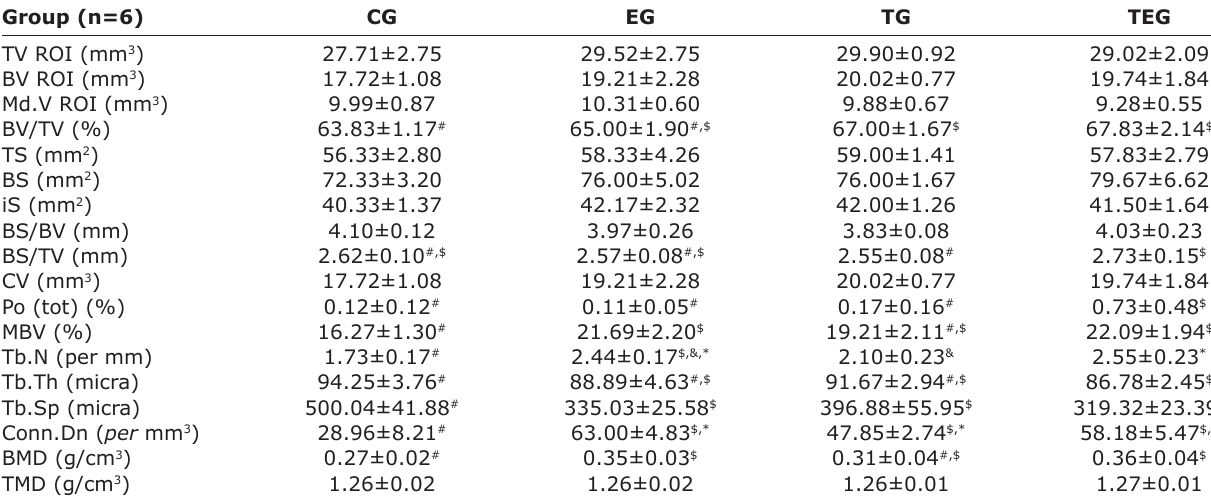
Table-2: Bone parameters addressed by micro-computed tomography (micro-CT) in all experimental groups (mean±standard deviation). Group